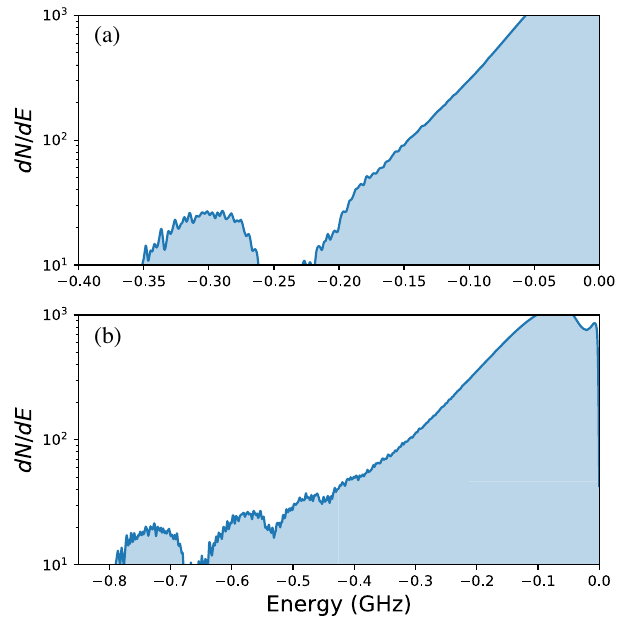
FIG. 13. The DOS for a ν ¼ 200 Rydberg composite formed with scatterers in a quasi-2D BEC in pancake geometry. The scatterers are randomly positioned with a uniform distribution in the xy plane and a Gaussian profile in the z direction. The cloud ’ s peak density and width (standard deviation) in the z direction are, 0 . 15 μ m in (a) and respectively, ρ ¼ 4 × 10 15 cm − 3 and δ z ¼ 0 . 3 μ min(b).Wehaveconvolvedthe ρ ¼ 8 × 10 15 cm − 3 and δ FIG. 14. Absorption spectra in arbitrary units from absorbing z ¼ linespectrawitha Gaussiandistribution of1 MHz width and use the two circularly polarized photons (see text) for the pancake − 16 . 1 a zero-energy electron-rubidium scattering length a Rydberg composite of Fig. 13 (black line) and the corresponding 0 . s ¼ DOS from Fig. 13 shown as blue shaded area. All parameters are The DOS is normalized by multiplying by a factor of 1 = ν as in as in Fig. Fig. 2(a).